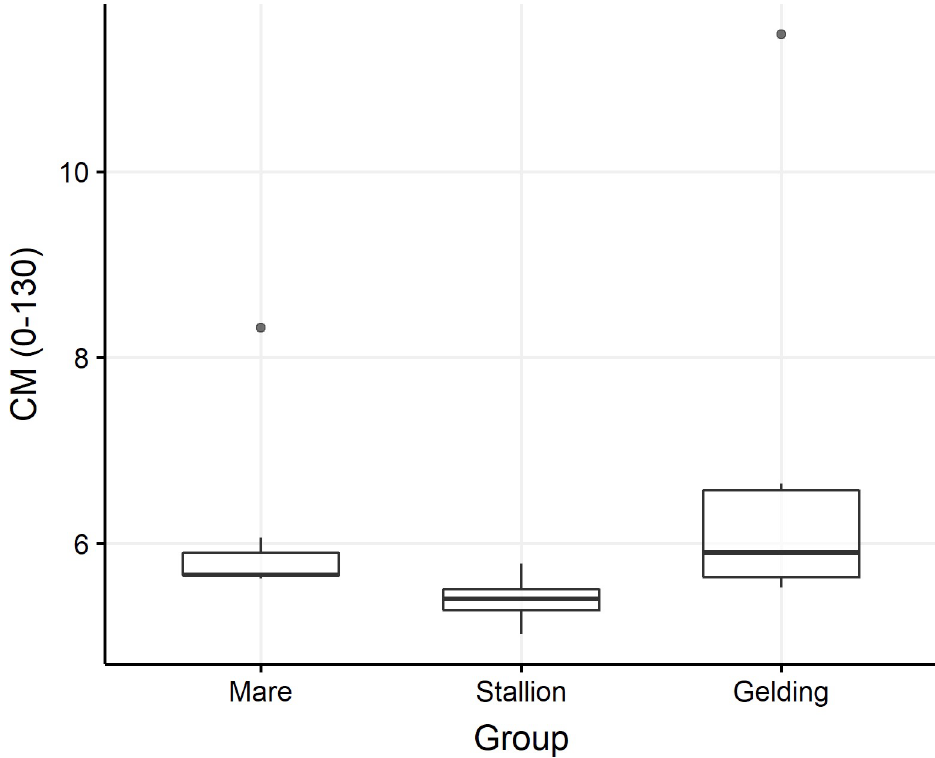
Fig 3. Corneometry values (CM) in the prosternum region. Data are expressed as a value in self units for the Corneometer 1 CM 825 probe. P < 0.05. The results were significantly higher between mares and stallions and between stallions and geldings.